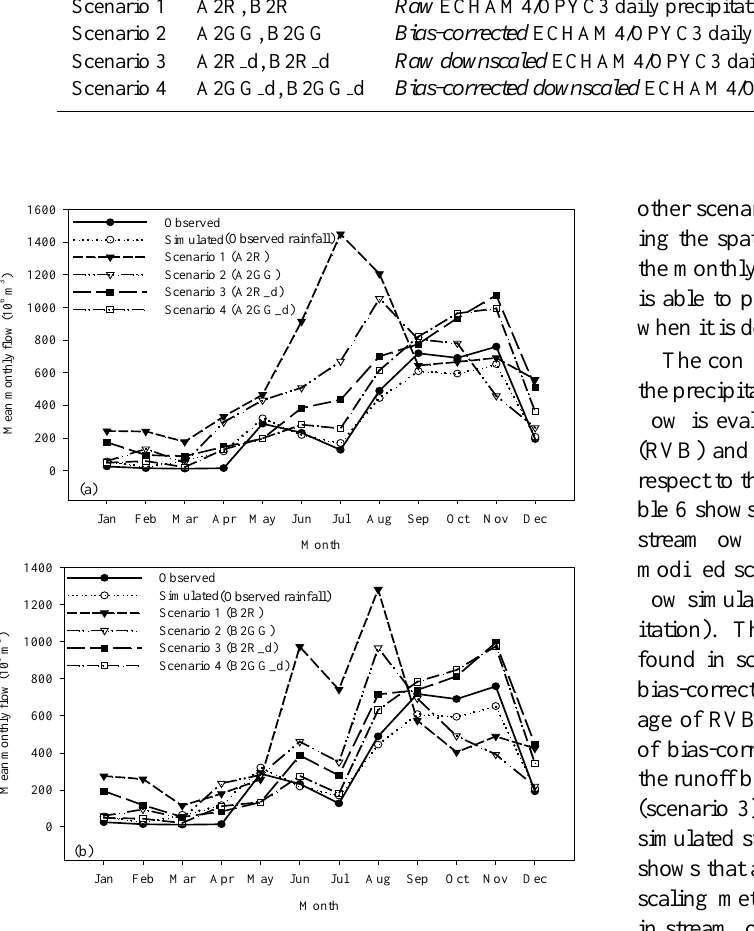
Fig. 14. Average monthly inflow to Bhumibol reservoir for the ob- served condition and the four modified precipitation scenarios (a) SRES A2, and (b) SRES